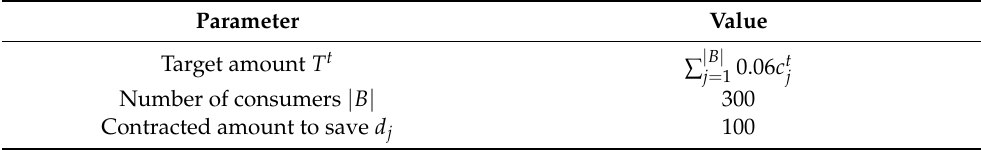
Table 2. Parameters in the simulation.